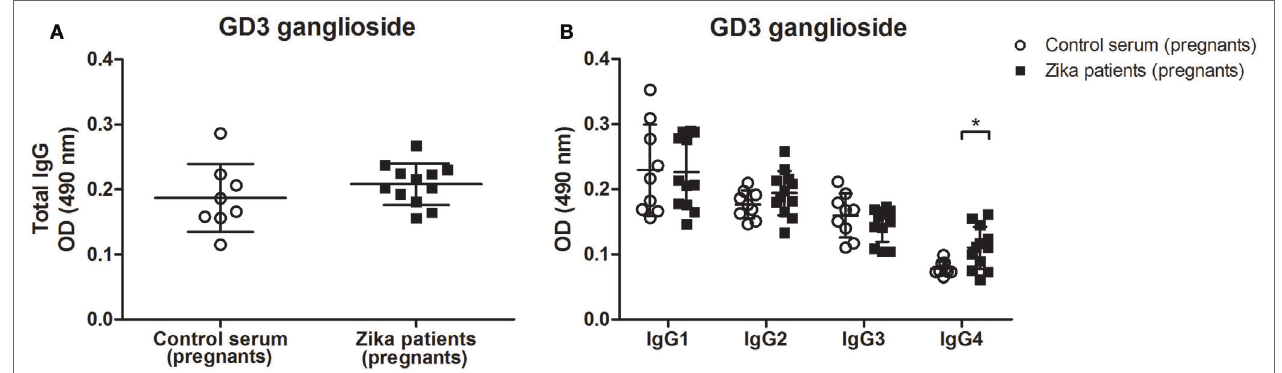
FigUre 3 | Increased levels of IgG4 autoantibody against to GD3 ganglioside in Zika virus infection during pregnancy. ELISA plates coated with GD3 ganglioside (20 µg/ml) were incubated with 1:100 dilution of sera from pregnant patients with Zika infection or control healthy pregnant individuals. The sera was obtained after pregnancy, and the reaction was developed with (a) anti-total IgG or (b) anti-Ig-specific subclasses conjugated to HRP. Scatter plots show individual values for each Zika-infected patient ( n = 12) and healthy individual ( n = 8). Means of data points for each individual ± SE are shown. Differences between groups are significant *( p ≤